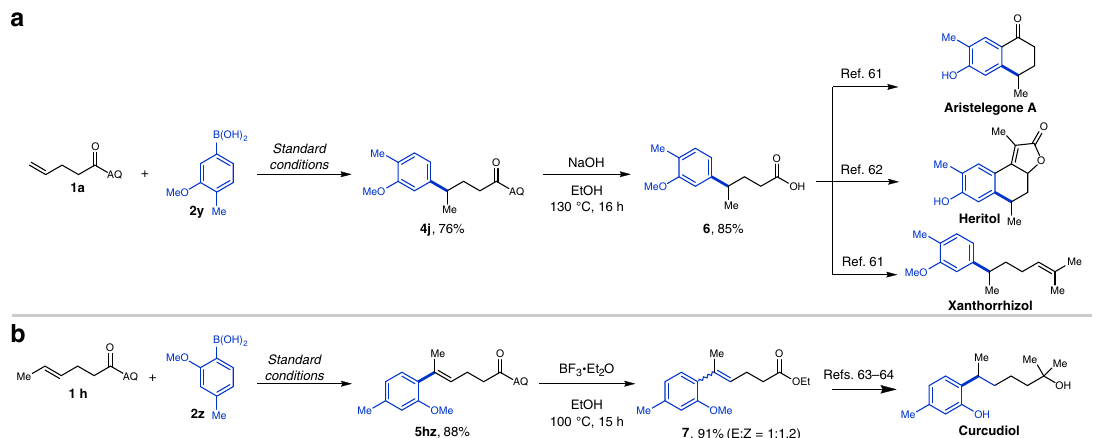
Fig. 2 Synthesis of key intermediates towards natural products. a The application of hydroarylation to approach the key intermediates in the synthesis of the natural products. b The application of oxidative Heck coupling toward the key intermediate in the synthesis of the natural product